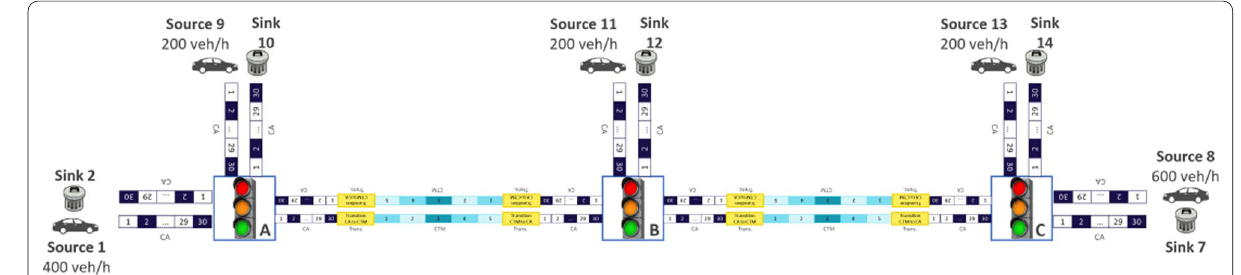
Fig. 8 Artery with three successive signalised junctions